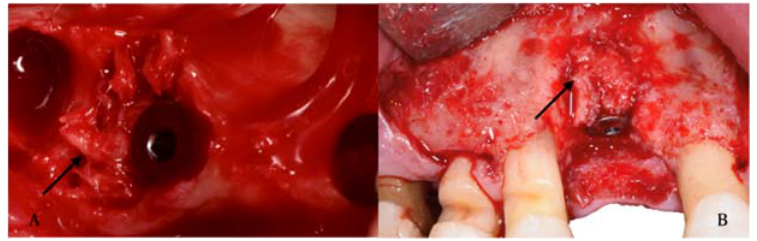
Figure 4. Examples of autografts in the peri ‐ implant site. ( A ) Autologous bone grafts in residual defect after post extractive implant, ( B ) autologous bone grafts on implant after peri ‐ implantitis.